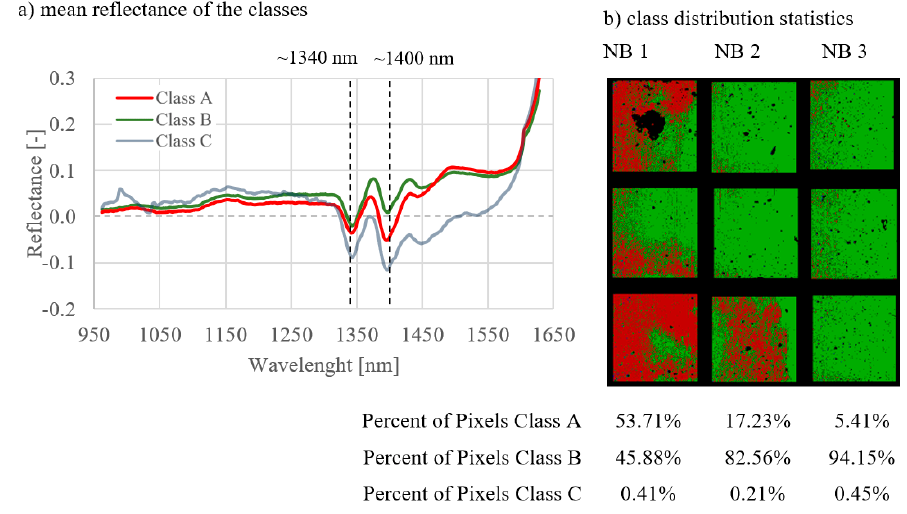
Figure 6. Results for combination 2; comparison of three curing types on day 7.